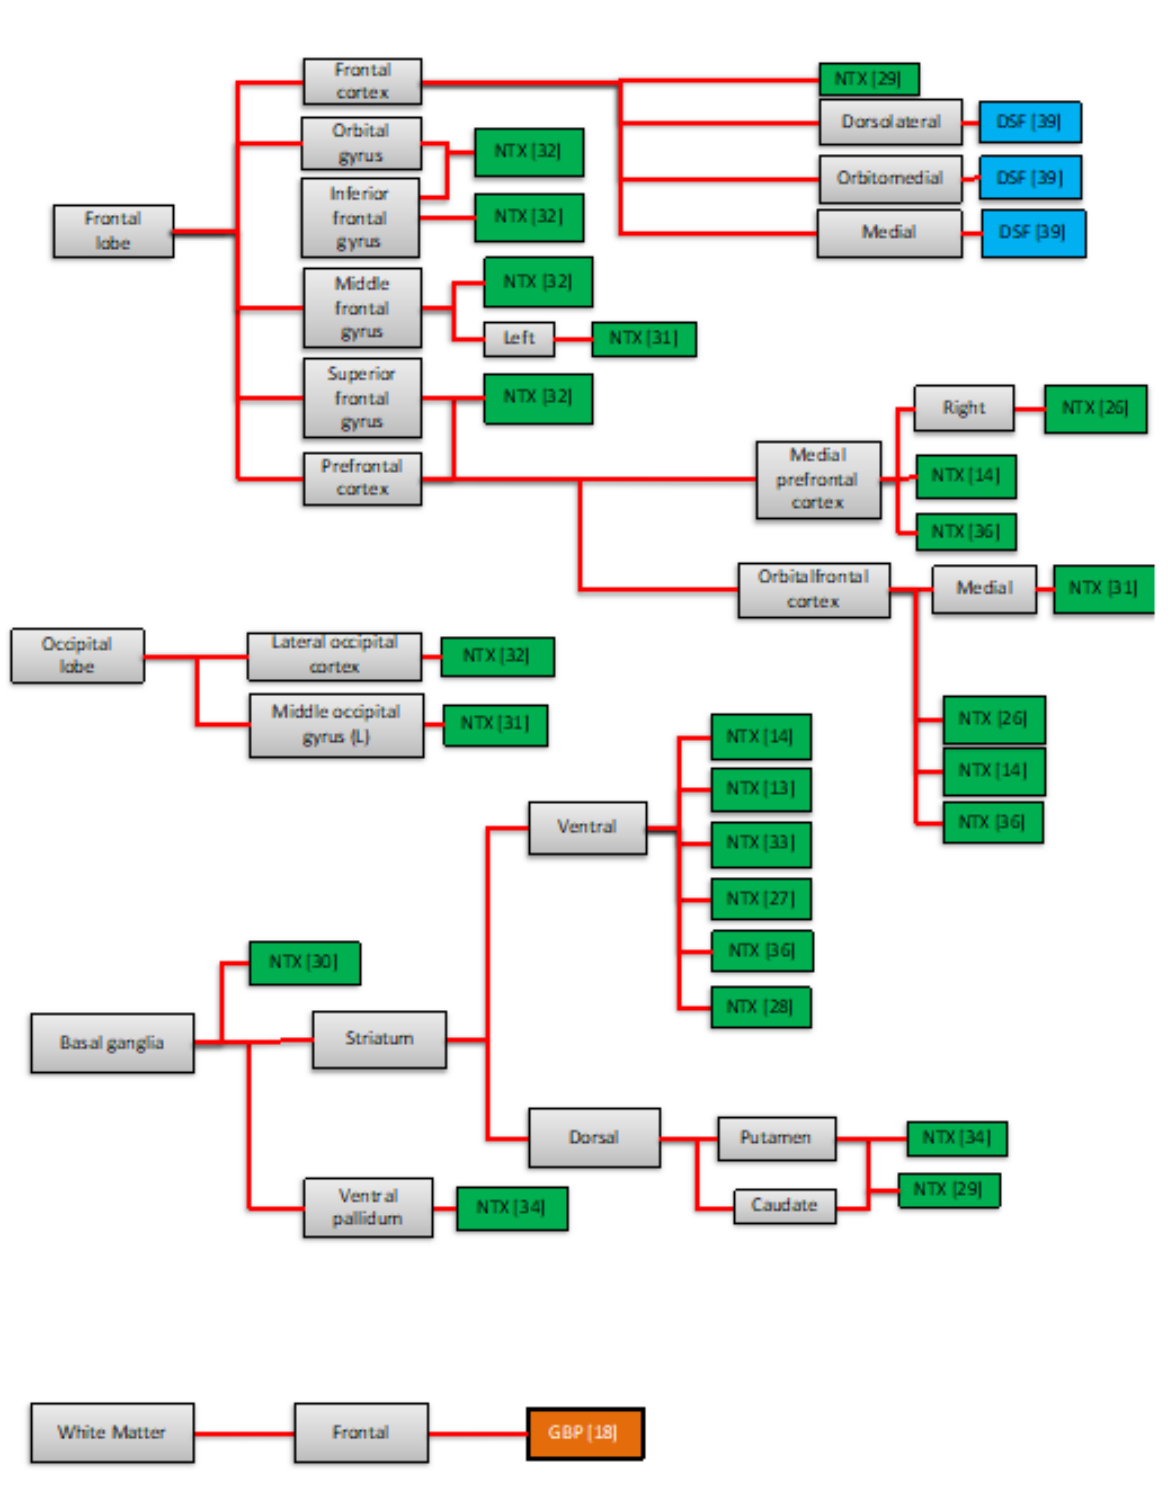
Figure 2. Neural areas affected by pharmacological treatment compared to placebo in neuroimaging